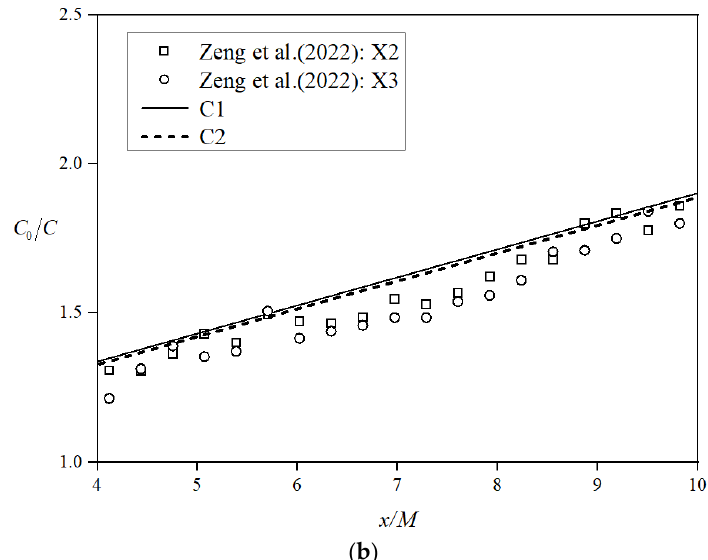
Figure 3. The comparison of the variation of ( a ) U / U 0 and ( b ) C 0 / C with longitudinal distance x / M along the flume centerline [8].